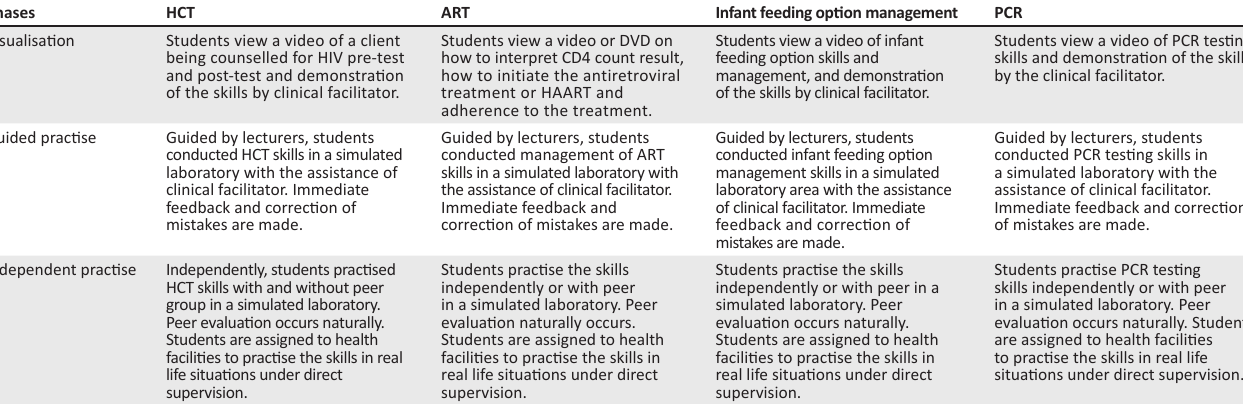
TABLE 1: Teaching prevention of mother-to-child HIV transmission competencies using the skills laboratory methodology. Phases